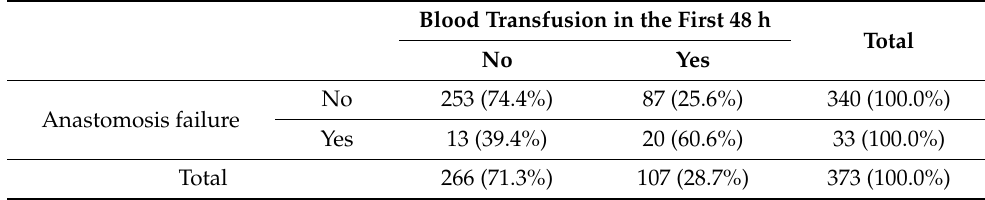
Table 2. Relationship between reoperations due to anastomosis failure and blood transfusion during the first 48 h.